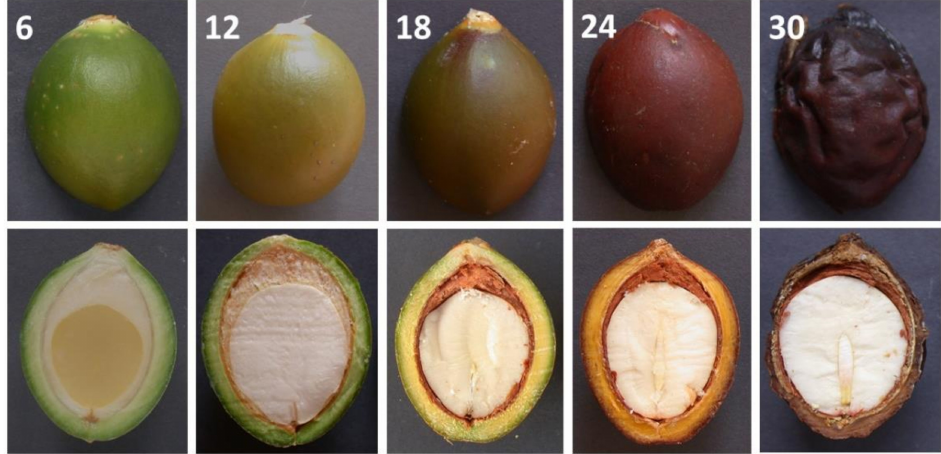
Figure 2. General appearance of Cycas micronesica seeds from 6 to 30 months in age (numbers in upper panel).